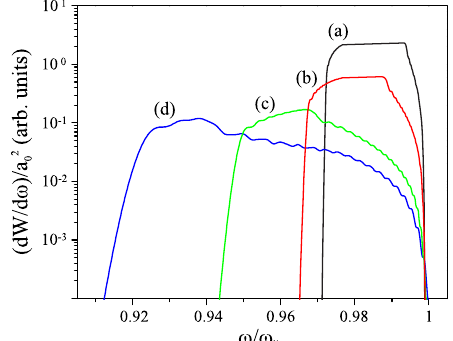
).FIG. 5. Position of the peak as a function of a 0 , for the same parameters as Fig. 1. The red curve is the curve 2 = ð 2 þ a 2 0 Þ